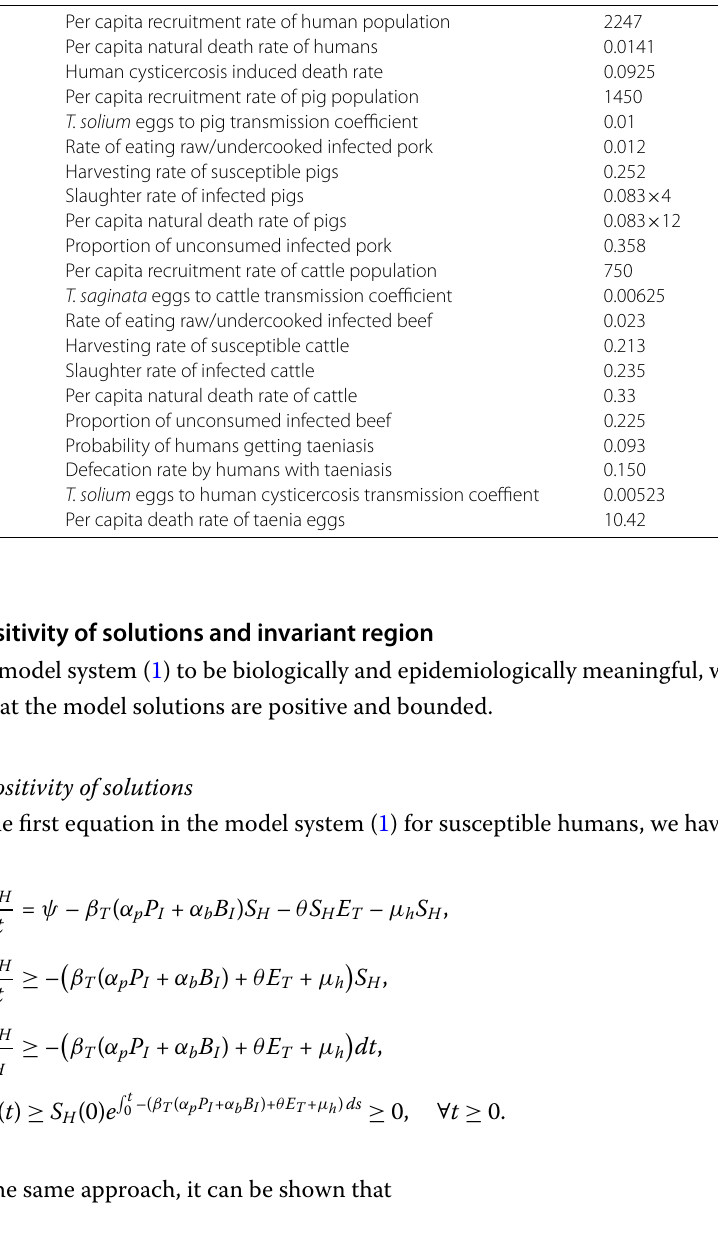
Table 2 Parameters’ description and their values (unit: yr –1 )